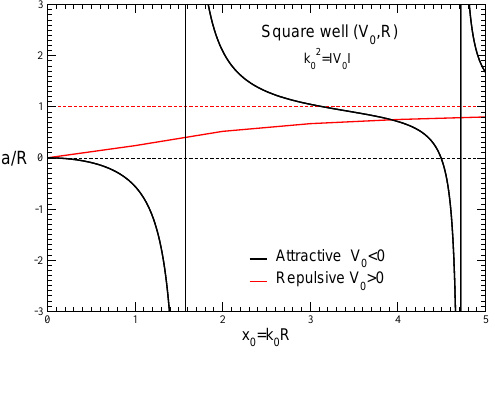
Figure 4: Scattering length in a square well potential with parameters ( V = (cid:112) V R . Solid red curve correspond to the function of its strength parameter x 0 0 repulsive case and solid black one to the attractive case. The later displays a pole singularity at the strength values x where a new bound states appears in the system, 0 ≈ 1.58 and x ≈ 4.72 e.g. x 0 0